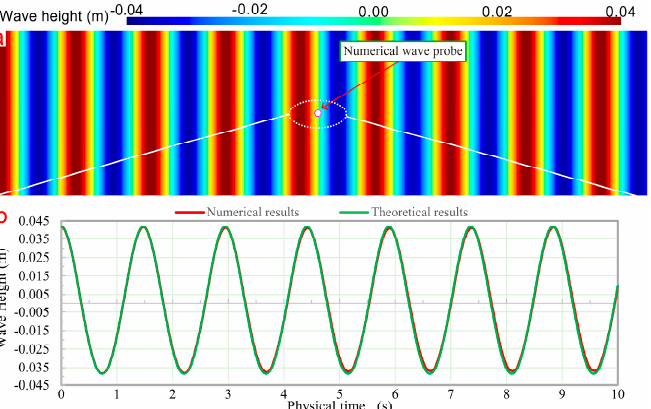
Figure 5. Comparison and verification of free surface wave height. ( a ) Waveform and wave height detection point; ( b ) Comparison of free surface wave height.